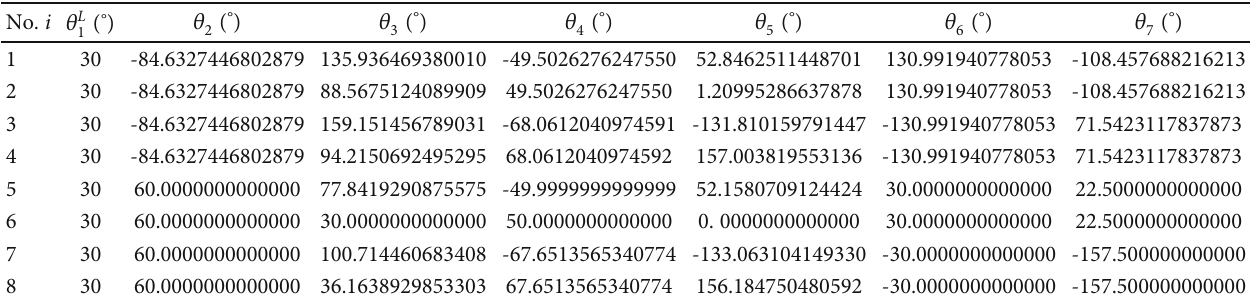
Table 2: The eight sets of solutions for locking the fi rst